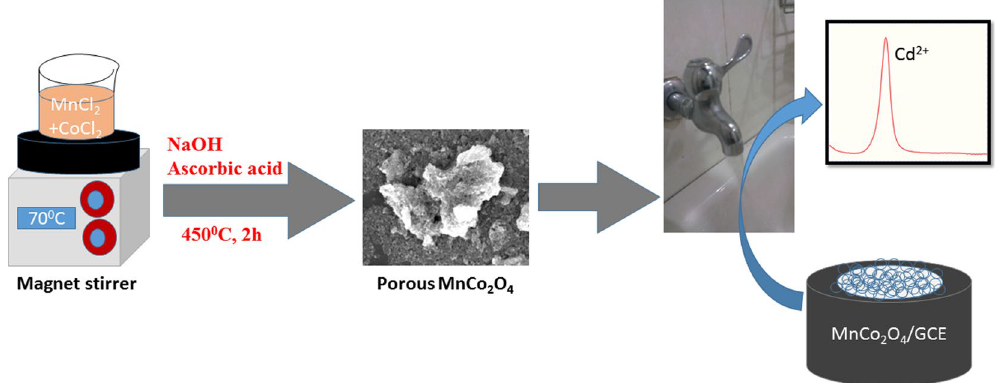
Figure 1. Preparation of porous MnCo 2 O 4 and electrochemical detection of Cd 2 + .